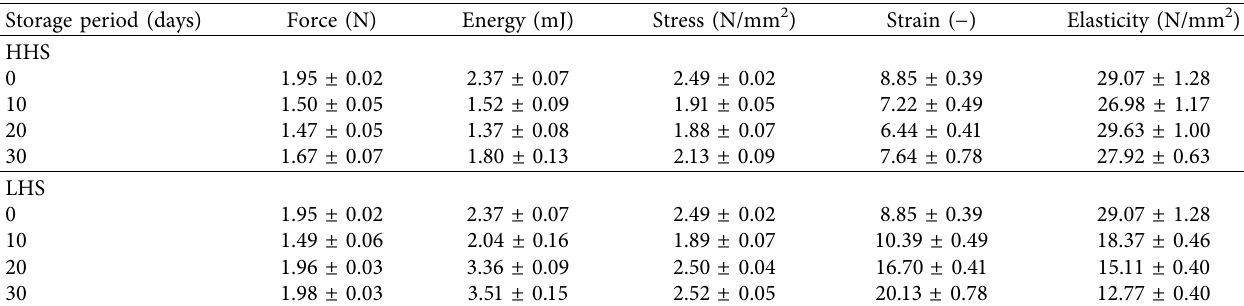
Table 1: Mechanical properties of “Shine Muscat” fruit at the breaking point during storage. Storage period (days)